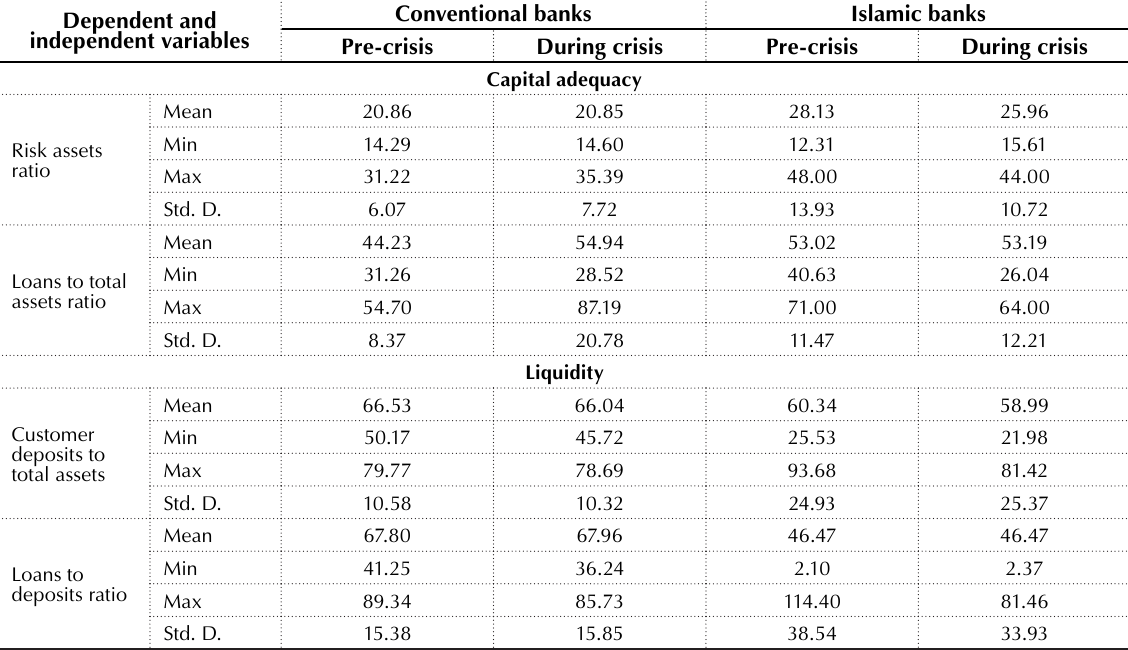
Table 3 (cont). Comparative performance – pre crisis and during crisis Dependent and independent variables